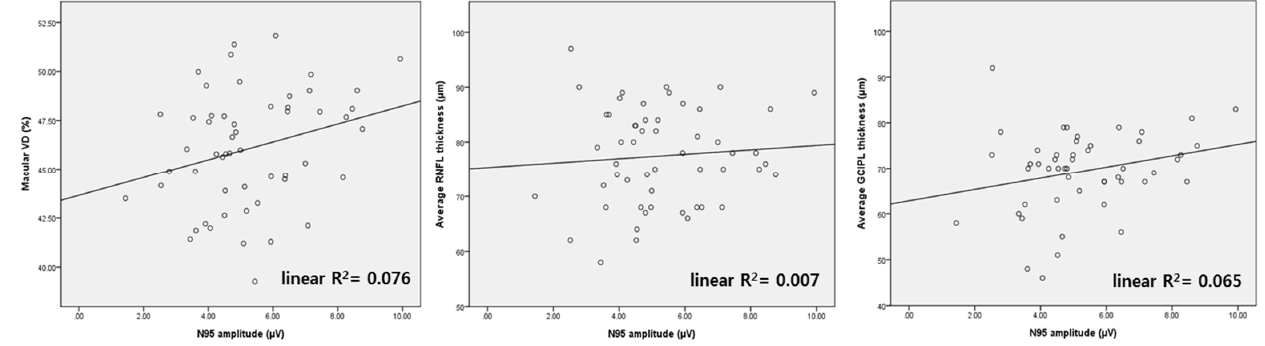
Figure 2. Scatter plots of N95 amplitude, macular vessel density (VD), and average RNFL thickness from mild glaucoma patients (MD ≥ − 6 dB). The scatter plot of macular VD shows the most linear association with N95 amplitude among the three parameters.